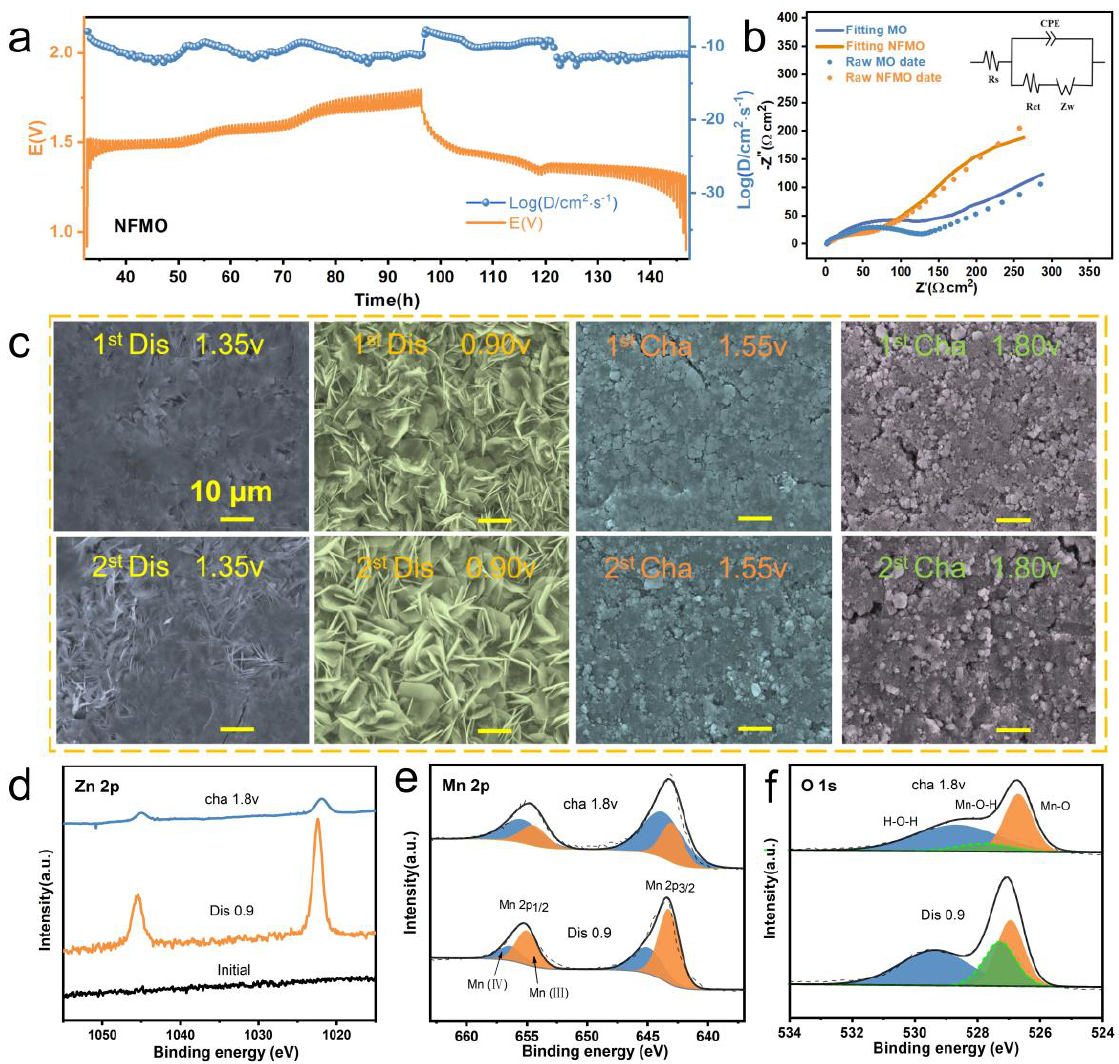
Figure 4. ( a ) GITT curves and diffusion coefficients calculated for NFMO at charge/discharge states. ( b ) The fitted EIS data of NFMO and NKMO cathodes. ( c ) Ex situ SEM images of the first two cycles of NFMO in different discharge/charge states. ( d ) Zn 2p, ( e ) Mn 2p, and ( f ) O 1s in the fully discharged and charged states.